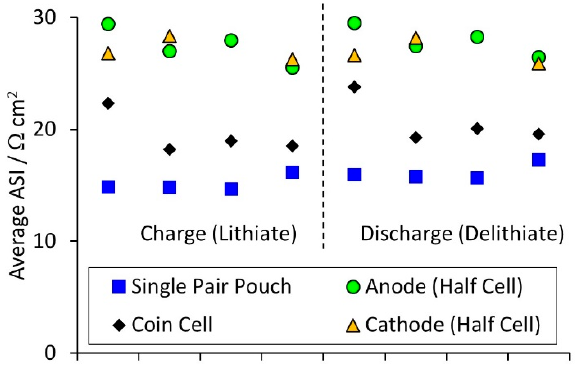
Figure 4. Averaged ASI